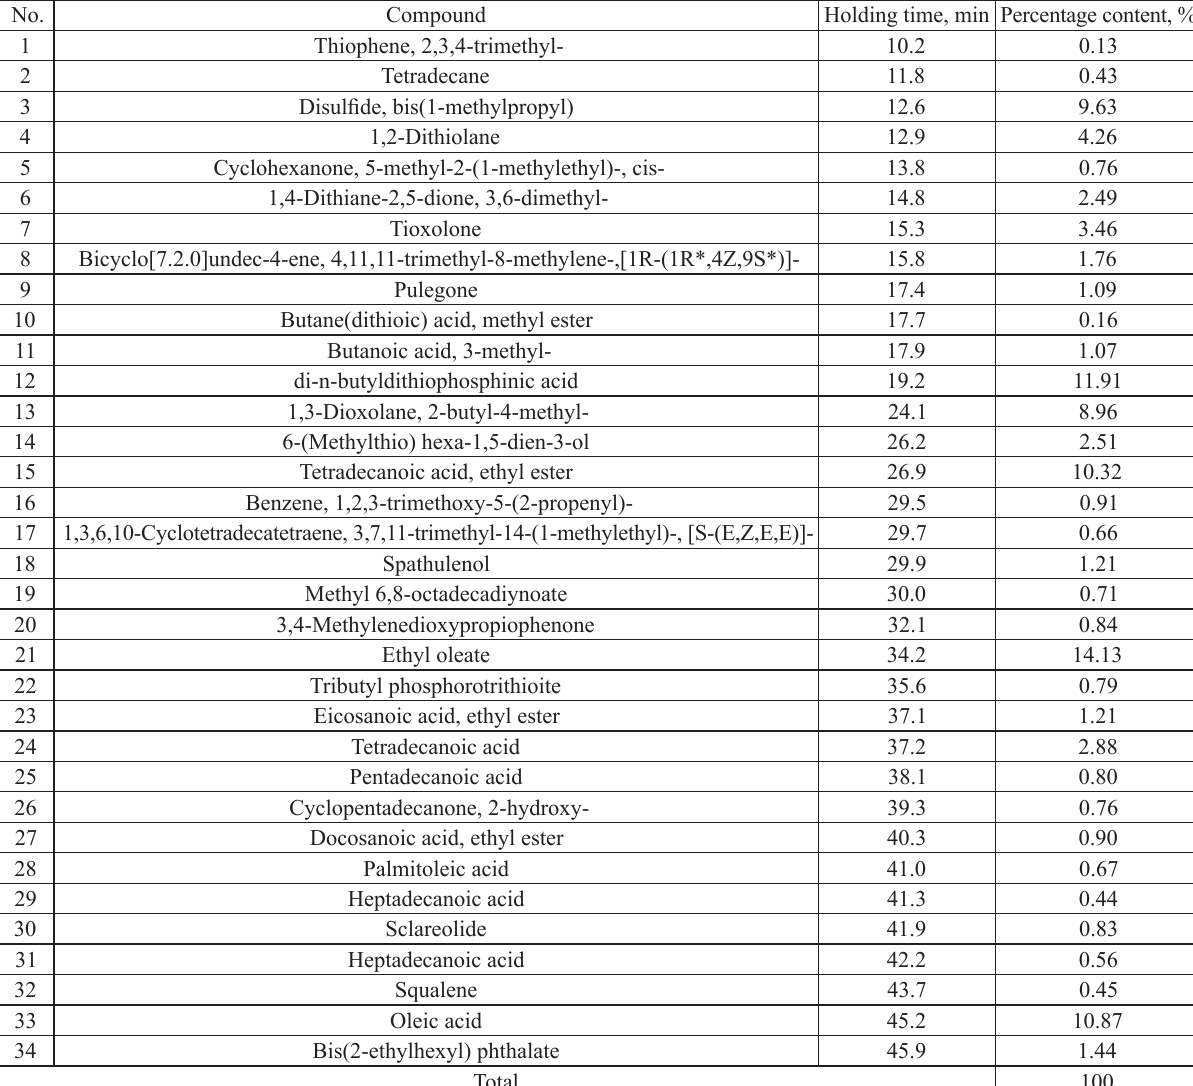
Chemical compounds identified during the study of the component composition of Ferula asafoetida L. extract obtained by CO 2